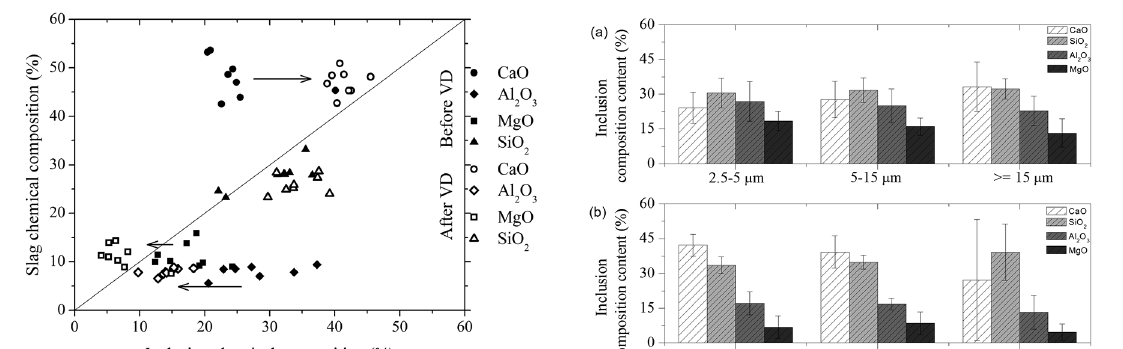
It can be seen from Figures 6a and 6b that there are no major differences between the different sized